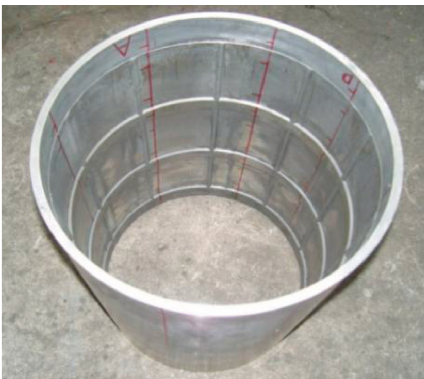
Figure 21: Sample of shell with longitudinal and latitudinal inner